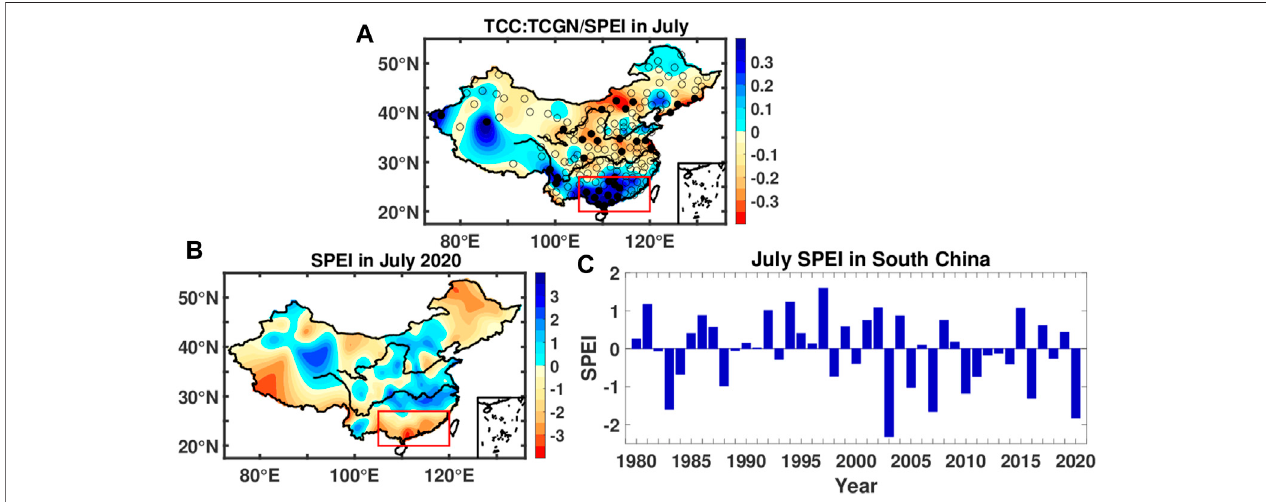
FIGURE 2 | (A) TCC between the July TCGN and the July SPEI in China during 1980 – 2020. Filled and open circles represent sites that passed and failed the signi fi cance test at the 95% level. (B) Spatial distribution of SPEI. (C) Standardized regional-averaged July SPEI in South China (20 ° – 27 ° N, 105 ° – 120 ° E).